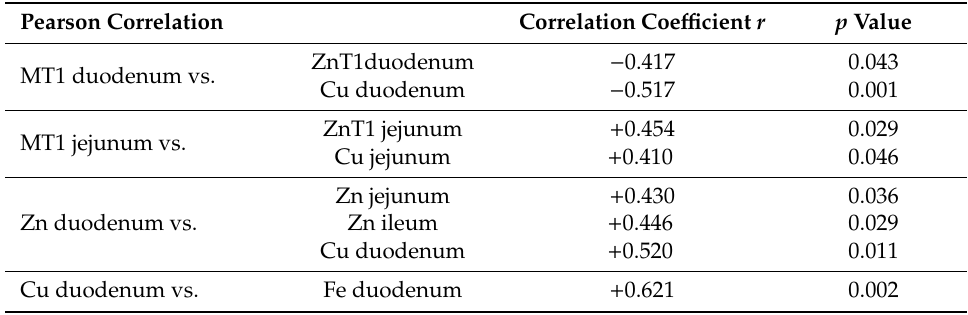
Table 6. Relationships between Zn transporters, trace elements and other parameters in tissues of piglets fed diets di ff ering in zinc and fibre